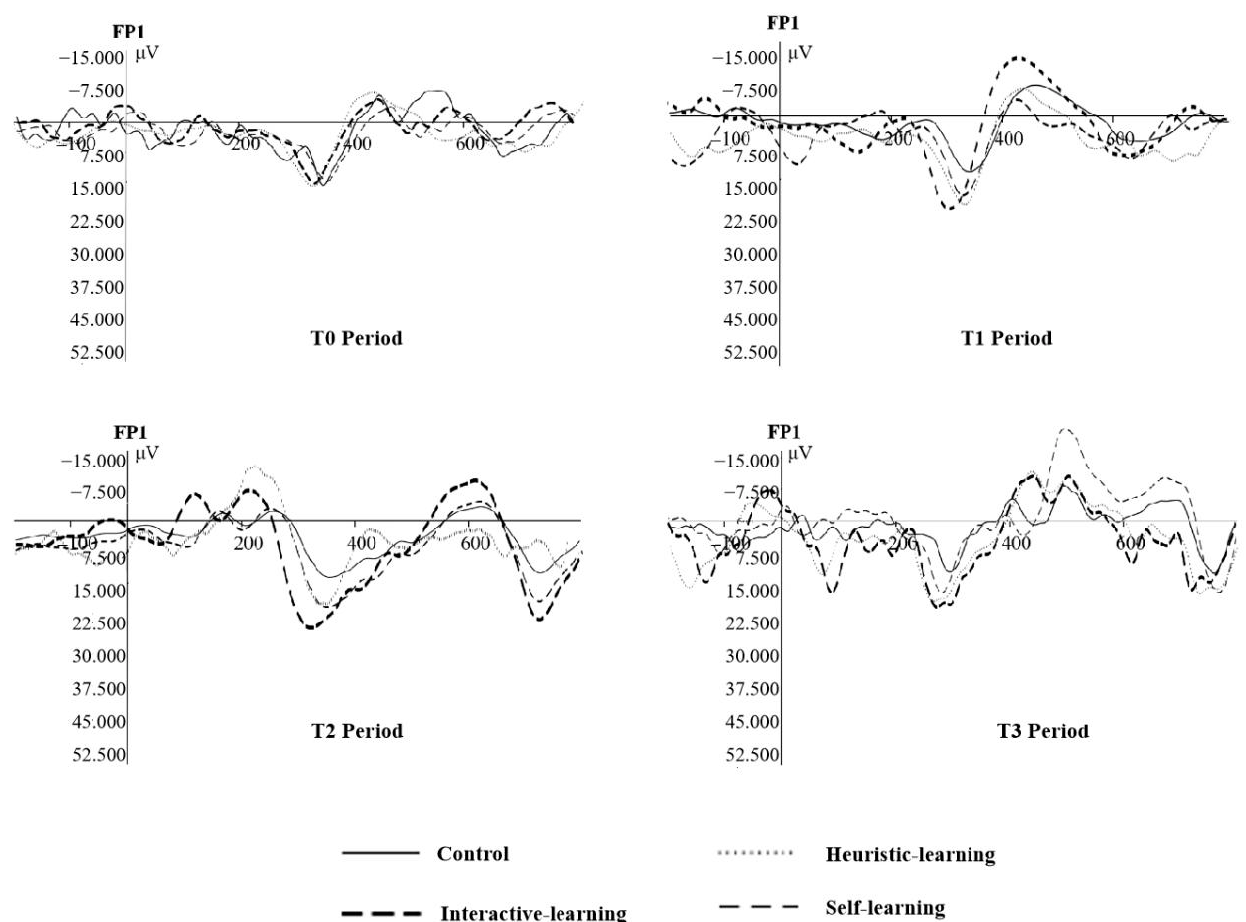
Figure 6. ERP induced by the classification judgement.